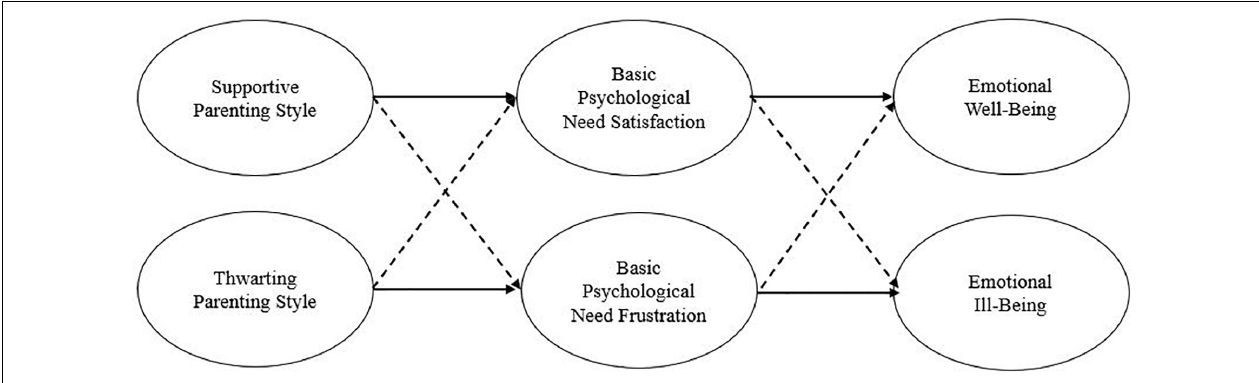
FIGURE 1 | The conceptual model of relationships between parenting style, basic psychological need, and well-being. The solid line indicates a positive relation. The dashed line indicates a negative